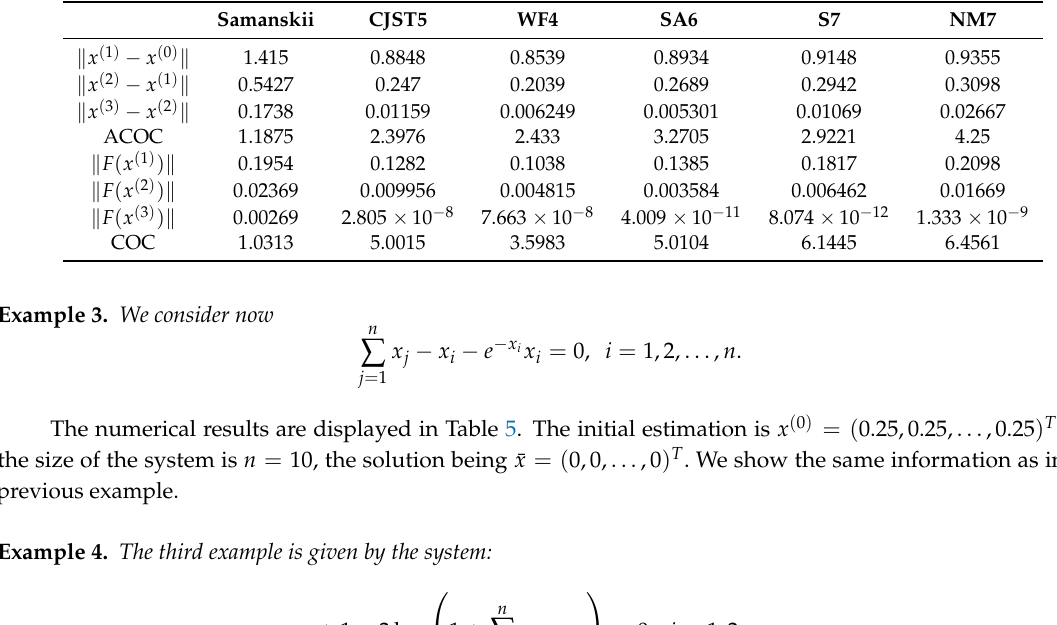
Table 4. Numerical results for Example